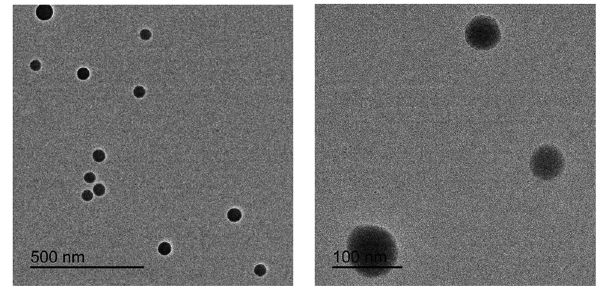
Figure 7: TEM images of nano - selenium.